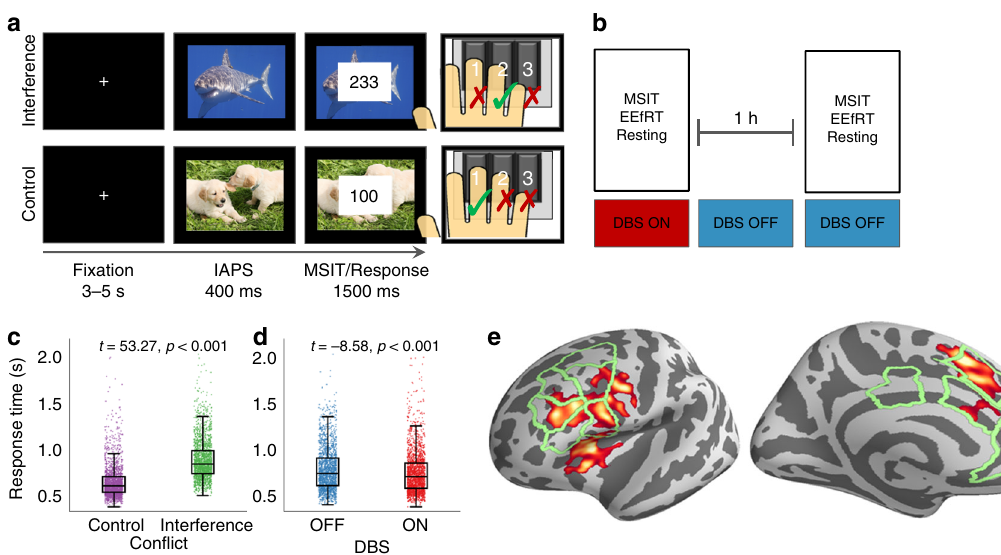
Fig. 1 Experiment design and behavior. a Affective multi-source interference task (MSIT). Subjects chose the number that differed from its neighbors while ignoring an emotionally arousing image. On interference trials (top), a non-intuitive motor mapping and fl anking distractors increased cognitive load. b Subjects performed task and resting recordings with deep brain stimulation (DBS) ON and again after 60 + minutes with DBS OFF. c Interference increased response times (RTs) ( n = 3785 trials from 14 subjects, t = 53.3, p < 1e – 20, Wald test of generalized linear model (GLM) coef fi cient). d DBS reduced RTs by 34 ms ( t = − 8.6, p < 1.33e – 17). Error bars represent standard error of the mean. e Atlas labels for source localization overlaid on